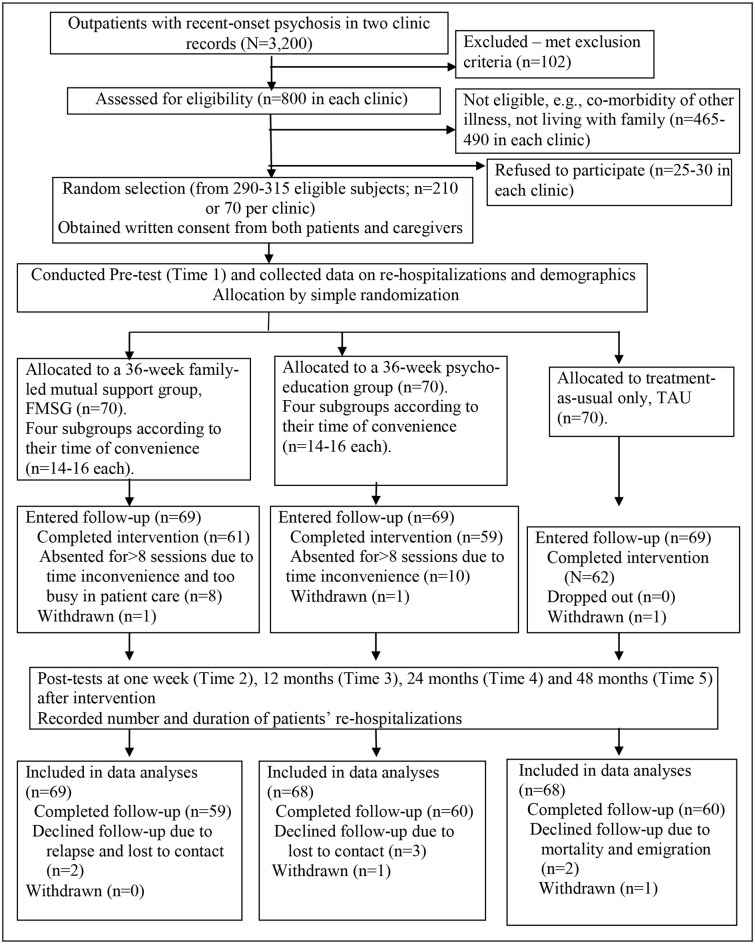
Flow diagram of the controlled trial procedure. The figure shows the main procedure of this randomized controlled trial according to the latest CONSORT statement (27). Families of patients with recent-onset psychosis in three outpatient clinics (N = 800 per clinic) were assessed and 290–315 of them were found eligible in this study. Two hundred ten of them (70 per clinic) were randomly selected and after baseline measurement, were then randomly allocated into one of the three study groups [Family-led Mutual Support Group (FMSG), Family Psychoeducation Group, or Treatment-As-Usual (TAU) only; 70 subjects per group]. After completion of the interventions, majority of them in the FMSG, Family Psychoeducation Group and TAU (n = 69 in each group) continued to be followed up for 48 months and only a few lost/withdrew from the study. On intention-to-treat basis, 69 in the FMSG and 68 in the other two study groups were included into final outcome analysis.